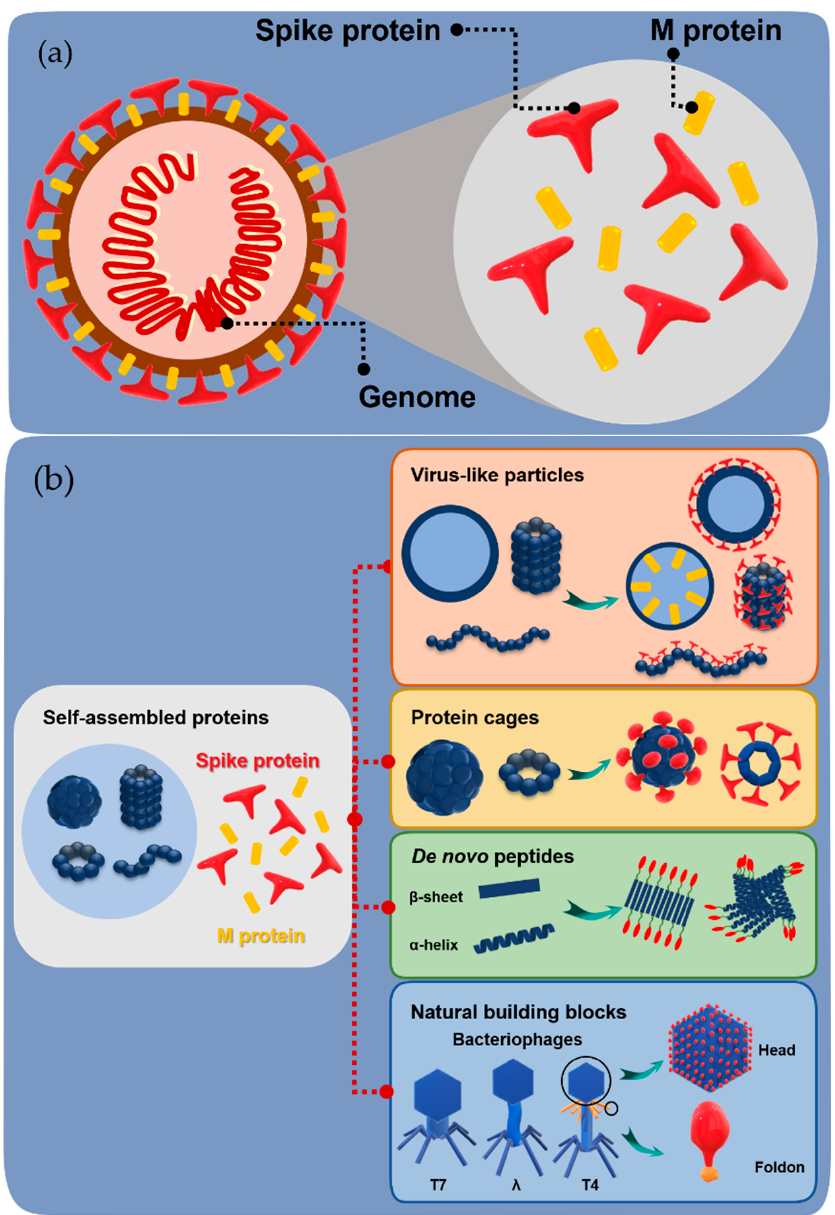
Figure 1. General structure of a pathogen and construction of subunit vaccines. ( a ) Schematic representation of the basic structure of a virus containing spike and membrane protein (M protein) on the surface and the genome inside. ( b ) Schematic representation of the construction of subunit vaccines by fusion of spike/M protein with various self-assembled